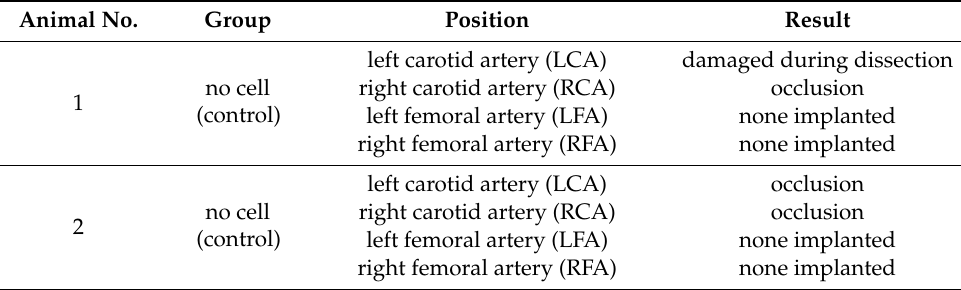
Table 1. The implanted vessels per position, and